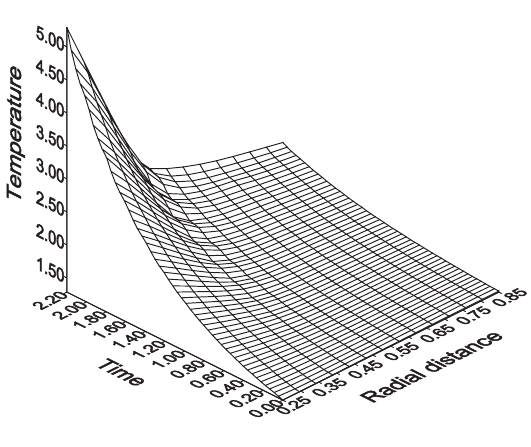
Figure 4.1 . Variation of the temperature with radial distance and time.